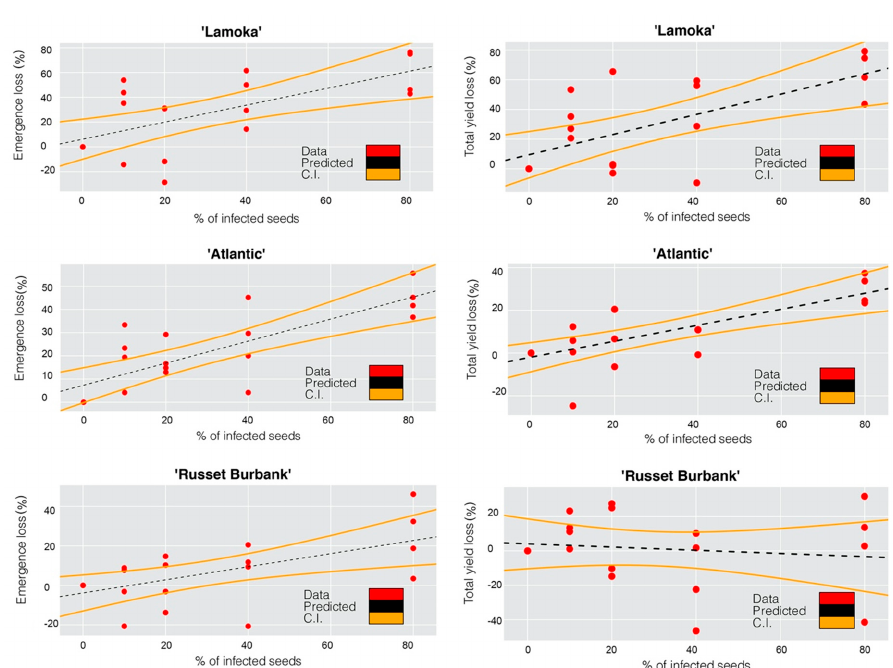
Figure 2. Disease incidence affected by infection of potato “Lamoka”, “Russet Burbank”, and “Atlantic” seed pieces inoc- ulated with Dickeya dianthicola in 2019.